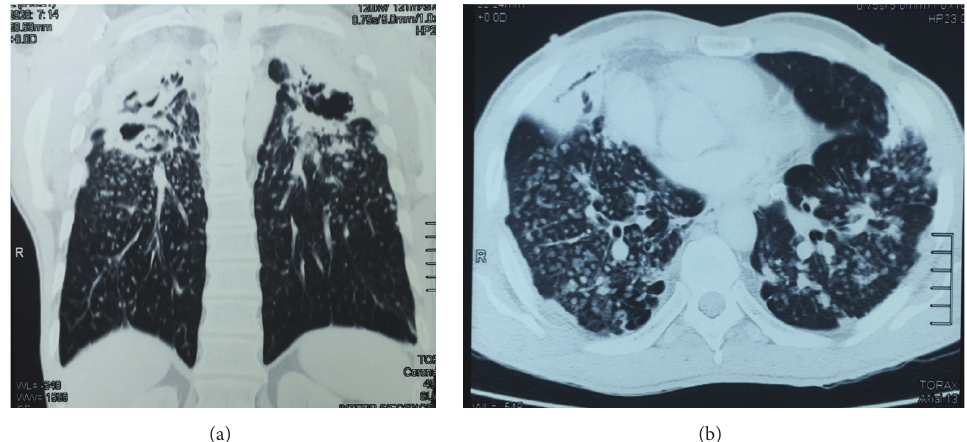
Figure 1: Thorax computed tomography: large pulmonary opacities in the upper lobes of both lungs, air bronchograms and calcifications, bilateral diffuse nodular infiltrates with areas of pleural thickening, nodular interstitial infiltrate associated with ground glass opacities, and cavitations with thick walls. (a) Coronal plane. (b) Axial